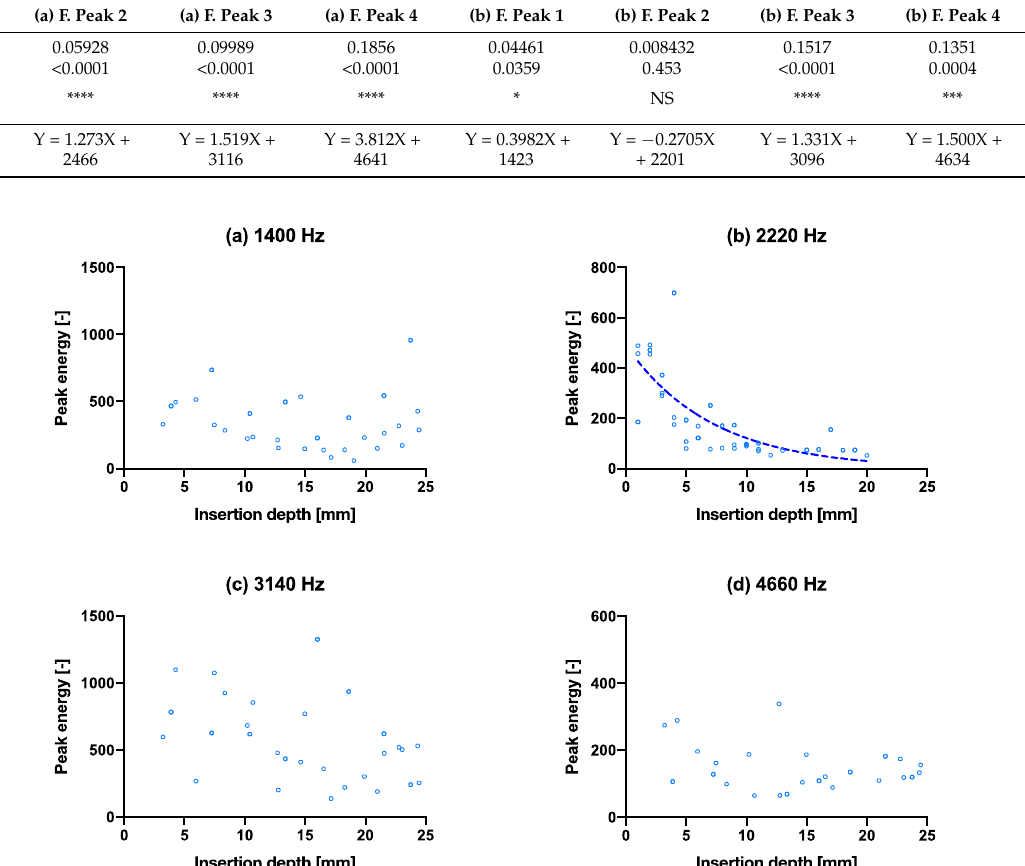
Figure 5. Capability of predicting fixation quality using the spread of data in peak energy vs. inser- tion depth. ( a – d ) are the isolated peak energies (smaller broach condition) for the four main peak frequencies at 1400 Hz, 2220 Hz, 3140 Hz and 4660 Hz, respectively, with exponential tren lines. The same graphs with hammer blows on the x -axis are shown in Supplementary Materials Figure